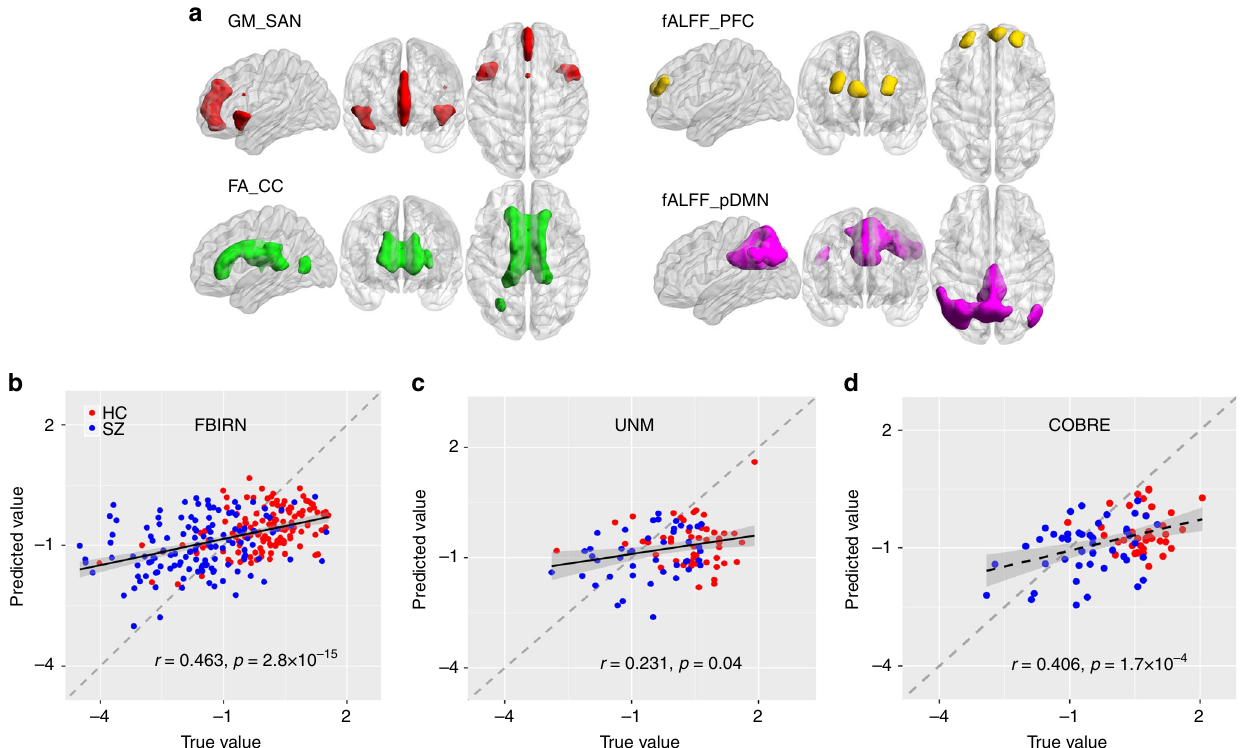
Fig. 7 Identi fi ed multimodal neuromarkers and the predictability on composite cognitive scores across three cohorts. a Four identi fi ed modality-speci fi c brain networks from FBIRN cohort that were used as regressors to predict individual cognitive scores. b Prediction of CMINDS composite scores based on linear regression of the four regressors (mean ROI values in a ). A correlation of r = 0.463 was achieved between the estimated CMINDS composite scores and its true values. c Generalization of the CMINDS prediction model in b to UNM cohort (41HCs/37SZs) to predict MCCB, r = 0.231. d Generalization of the CMINDS prediction model in b to COBRE cohort (42 HCs/46SZs) to predict MCCB, r = 0.406. In both c and d , good generalizability of the proposed prediction model were validated. The gray regions in b – d indicate a 95% con fi dence interval was achieved between the estimated MCCB composite scores and its true values